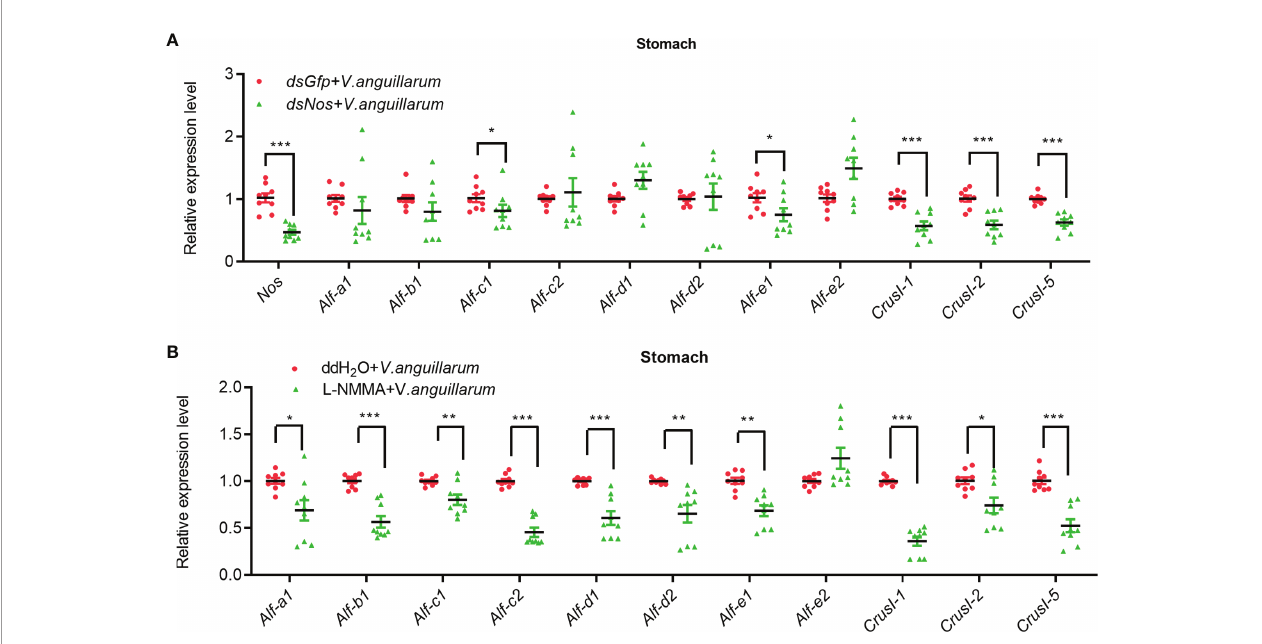
FIGURE 5 | The expression of AMPs was inhibited in the stomach of shrimp after knockdown of Nos and L-NMMA treatment with bacterial challenge. (A) After knockdown of Nos , the mRNA expression levels of AMPs (ALF and CrusI families) in stomach of shrimp with bacterial challenge were detected by qPCR; dsGfp injection was used as the control. (B) The mRNA expression level of AMPs in stomach of L-NMMA-treated shrimp with bacterial challenge; ddH 2 O treatment was used as the control (* p < 0.05, ** p < 0.01, *** p < 0.001).